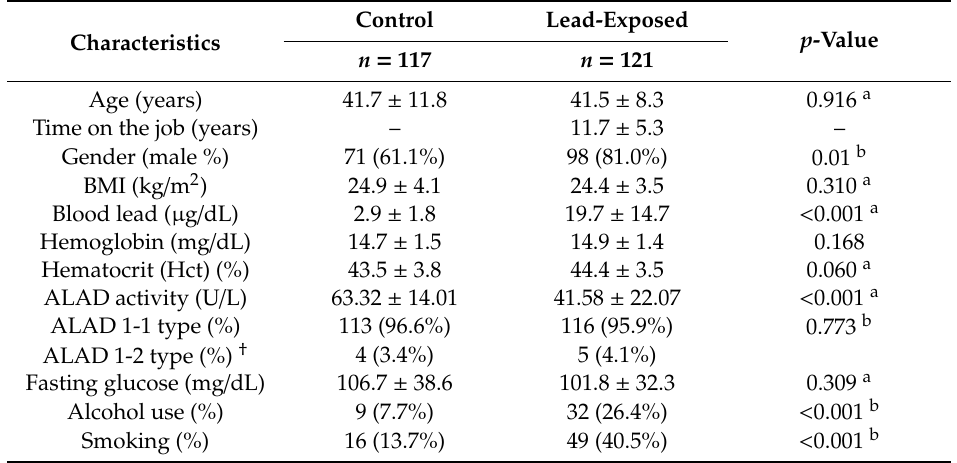
Table 1. Comparison of the characteristics of the control and lead-exposed groups.